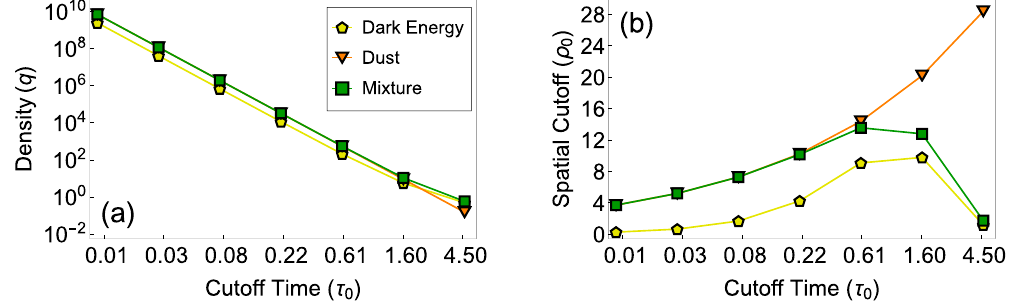
Figure 4. Rescaled sprinkling density and spatial cutoff as functions of the temporal cutoff in Fig.